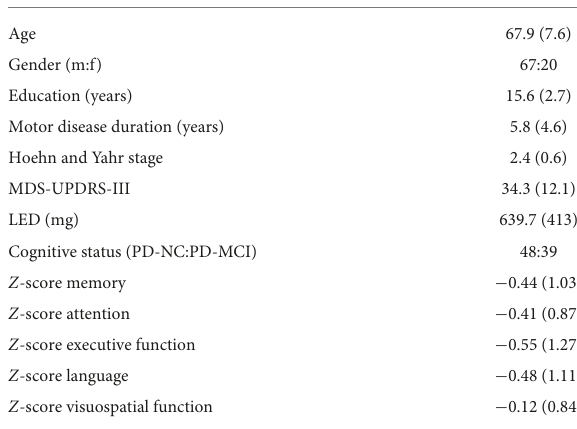
TABLE 1 Demographic and clinical characteristics of included Parkinson’s disease (PD)